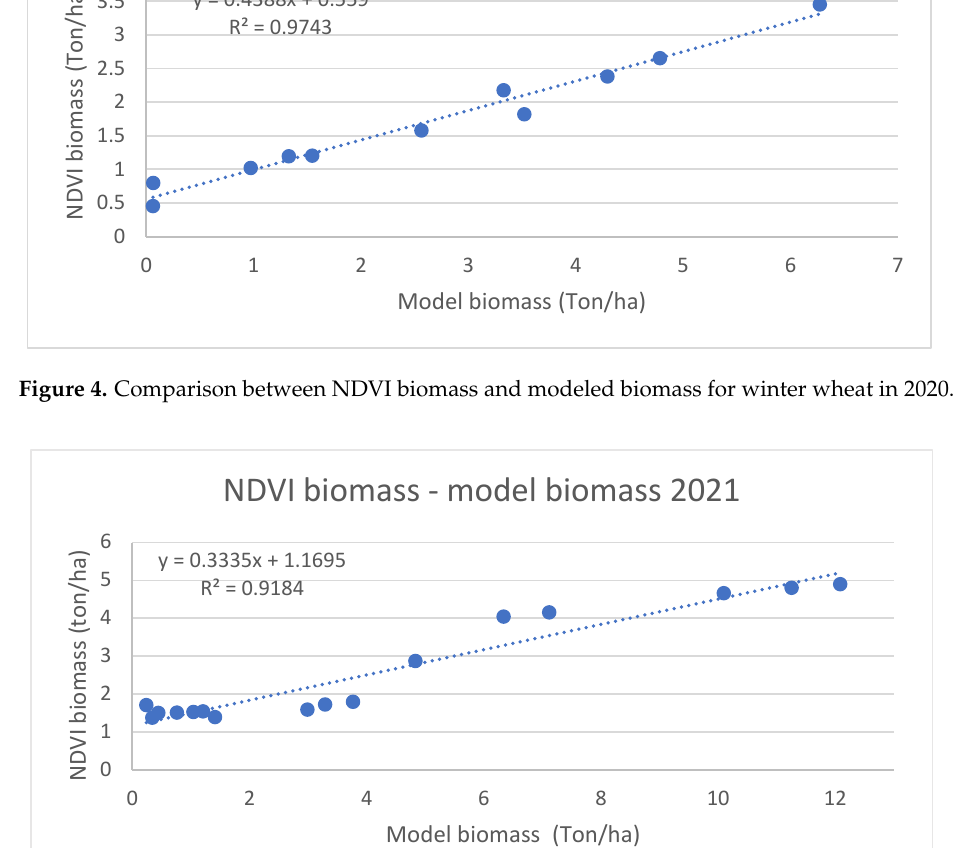
y = 0.4388x + 0.559 R² = 0.9743